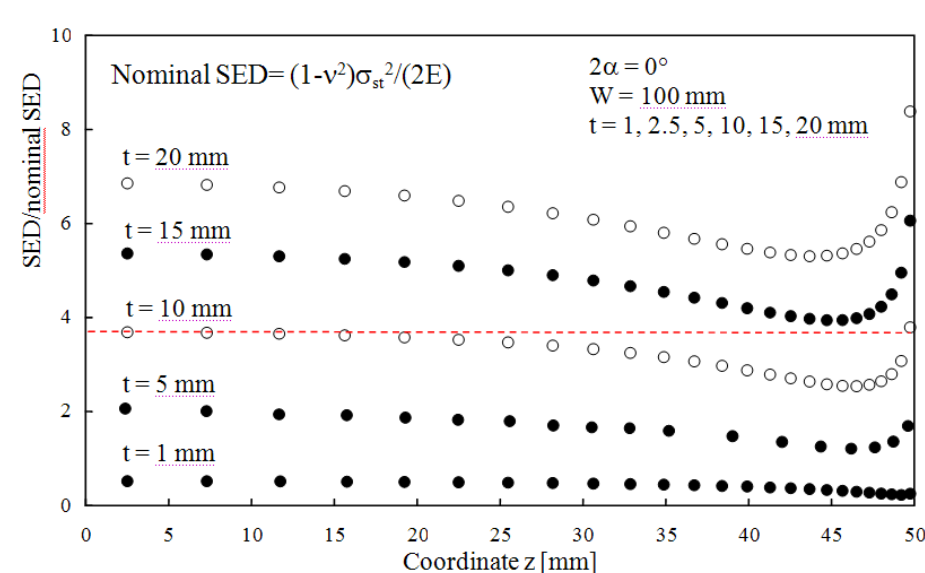
Figura 13: Andamenti della densità di energia di deformazione locale (SED) per differenti spessori del piatto principale. Modelli tridimensionali con d=2t; SED calcolata su un volume cilindrico di raggio e altezza R 0 =0.28 mm (da Harding et al.